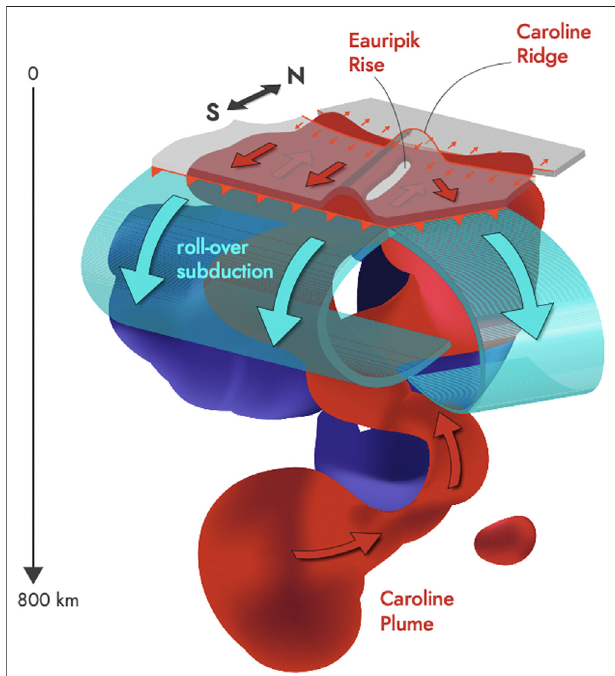
FIGURE 4 | Schematic interpretation of the dynamics of upper mantle and mantle transition zone beneath the Caroline plate. The fi gure illustrates that the Caroline plate is moving southward, subducting under the Australian plate. The ridge push force is much larger than the trench migration velocity from the Australian plate, due to a relatively large volume of plume supplied from thebase. Thiscan lead toan advancing subduction regimeand a roll-over slab geometry, as observed in our seismic velocity model ( Figure 2 ). The Caroline plume upwelling from the core – mantle boundary or deep mantle is hot and soft, and thus takes a detouring path that avoids the subducting slabs within the region. See Supplementary Figure S13 for